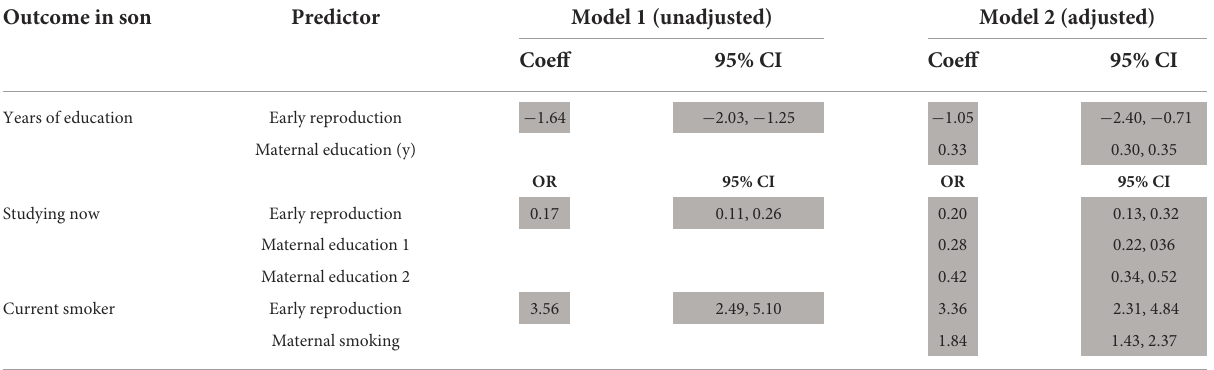
TABLE 6 Linear regression models analysing associations of early reproduction with components of son phenotype, without/with adjustment for the same or similar component of maternal phenotype. Outcome in